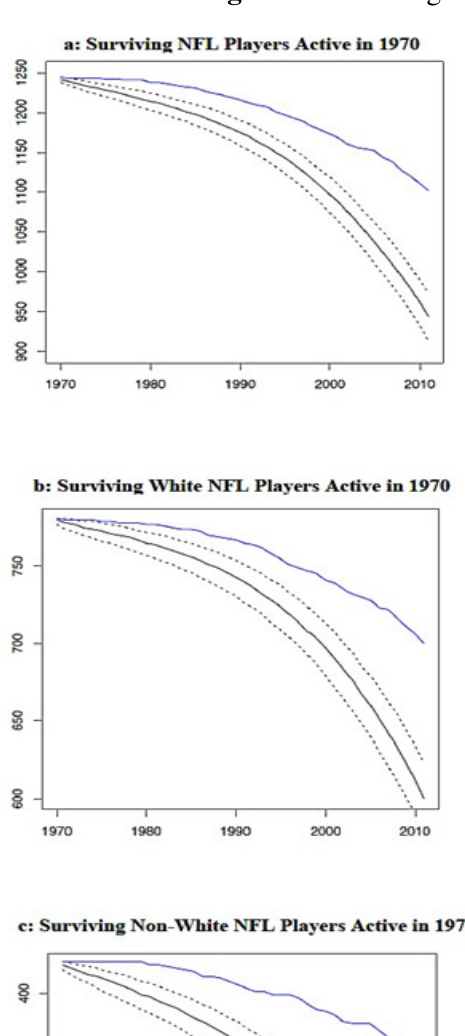
Figure 1. Surviving NFL Players by Year and